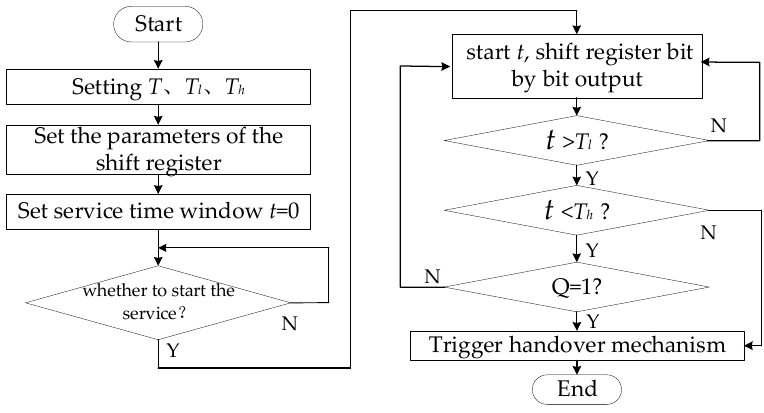
Figure 7. SWIM service dynamic migration trigger mechanism process.